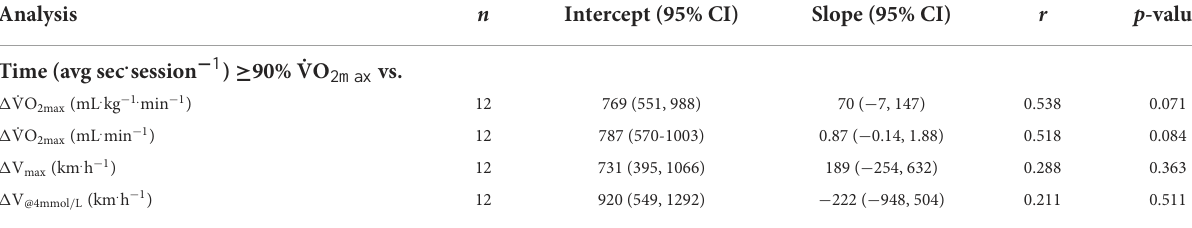
TABLE 4 Simple linear regression analyses for the relationship between time ≥ 90% of ˙VO 2max during HIT sessions and main training responses in BLOCK. Analysis n Intercept (95% CI) Slope (95% CI) r p -value Time (avg sec . session − 1 ) ≥ 90% ˙VO 2max vs. 1 ˙VO 2max (mL . kg − 1. min − 1